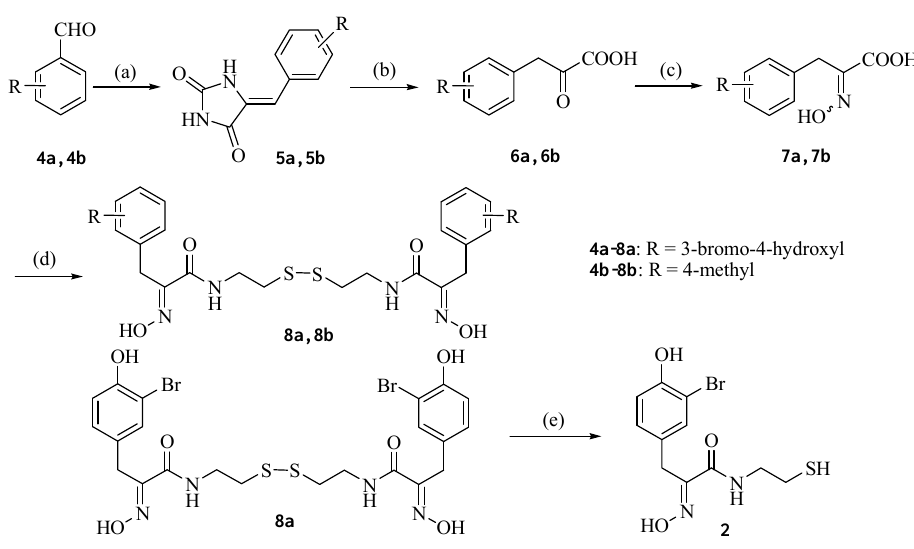
Scheme 1. Synthetic route to the target compound 2